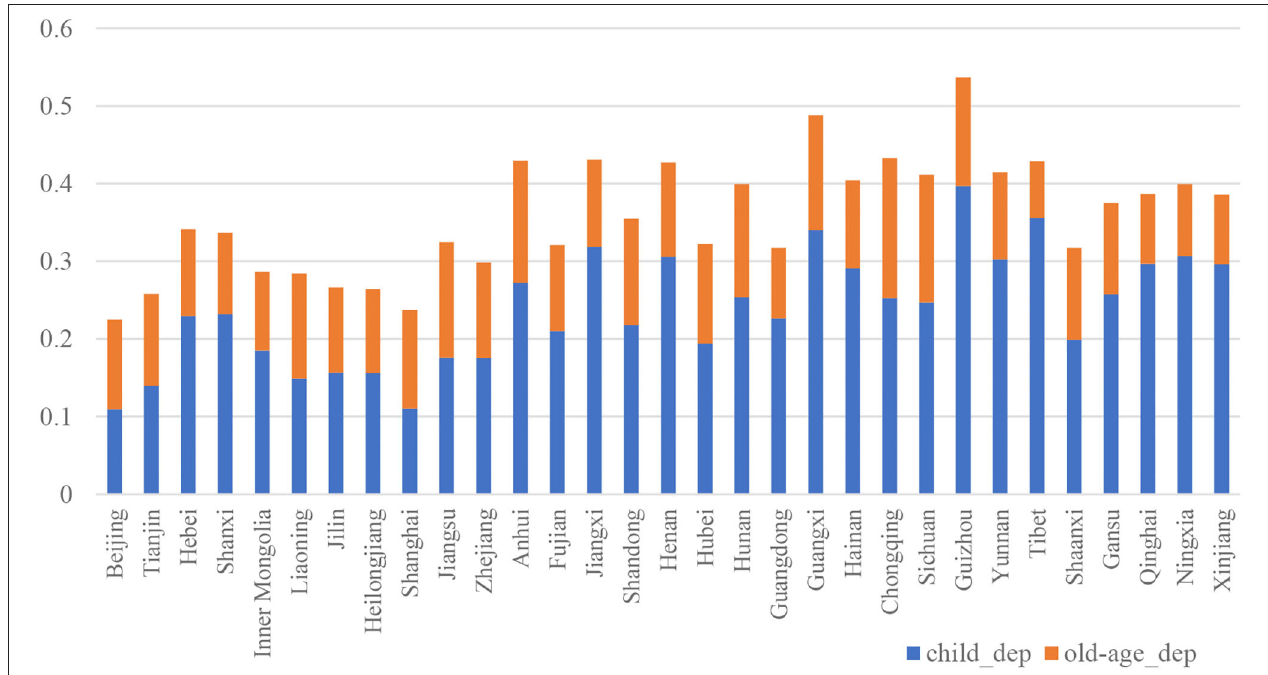
FIGURE 1 | Child dependency ratio and old-age dependency ratio of each